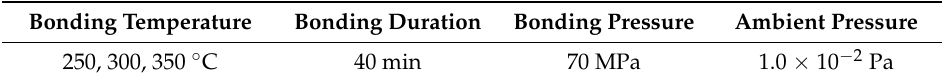
Table 2. Cu-Cu bonding